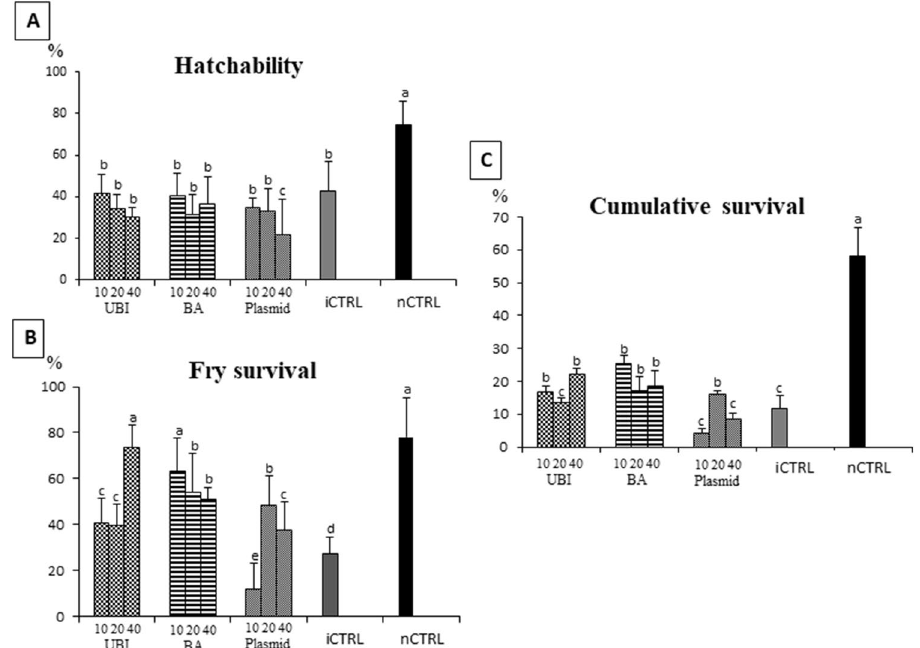
Figure 5. Plots of ( A ) embryo hatchability, ( B ) early fry survival and ( C ) cumulative mortality (hatchability x early fry survival) of channel catfish ( Ictalurus punctatus ) microinjected at one-cell stage with three transgene constructs: UBI (dsDNA driven by zebrafish ubiquitin promoter), BA (dsDNA driven by carp β-actin promoter) and plasmid (plasmid DNA construct with zebrafish ubiquitin promoter) at different concentrations (10, 20 and 40 ng/μL) carrying the alligator cathelicidin gene utilizing the CRISPR/Cas9 system. Control groups included the injected control (iCTRL, 60% phenol red solution only) and non-injected control (nCTRL). The values represent mean ± SD and analyzed by one-way ANOVA followed by Tukey’s test. Means with different letters are significantly different ( p < 0.05); N = 300–435 embryos injected.